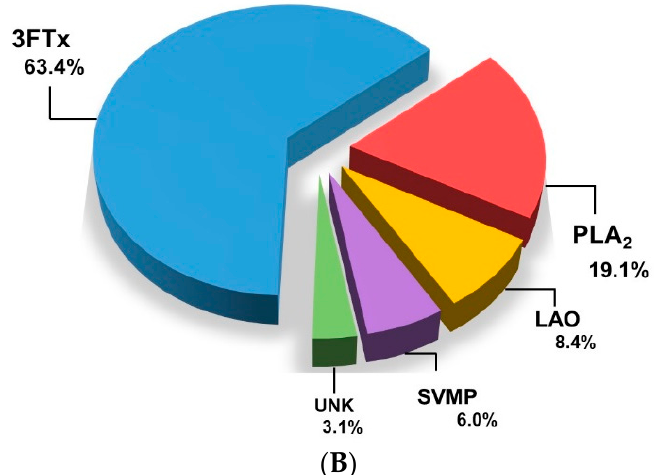
Figure 5. Proteomic insights into two Ecuadorian coral snake venoms. The pie charts represent the relative abundance of protein families found in the venom proteome of ( A ) M. helleri and ( B ) M. mipartitus . The relative abundance of protein families is expressed as % of the total venom toxin content, estimated based on chromatographic peak areas. UNK: unknown/unidentified.